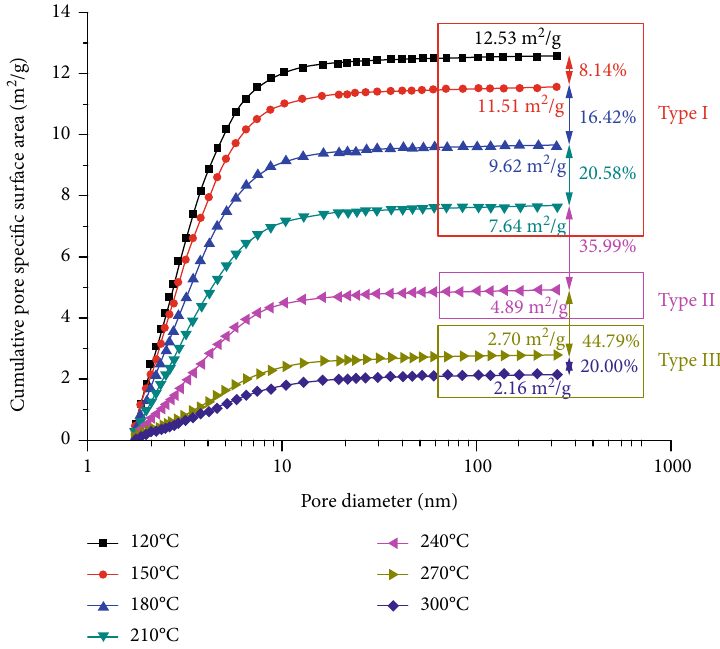
Figure 7: The cumulative pore speci fi c surface area under various treatment temperatures.